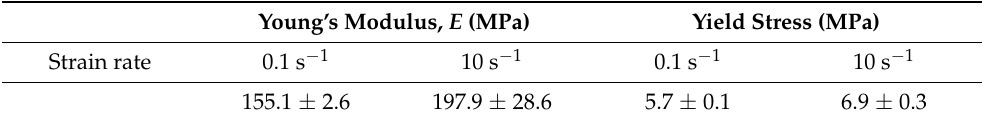
Figure 4. Nominal stress-nominal strain curves for PU20 obtained from dynamic uniaxial compres- sion testing at high strain rates. Table 5. Experimentally measured material properties for PU20 under uniaxial compression at two strain rates (0.1 s − 1 and 10 s − 1 ). Results are reported as mean ± SD (range). Johnson–Cook plasticity model material parameters for PU20.